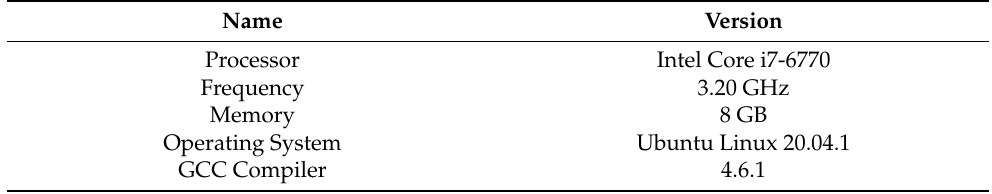
Table 5. The experimental setup and configurations of hardware and software.